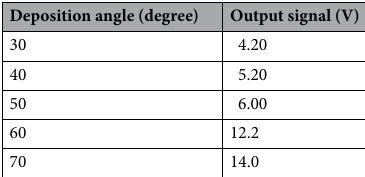
Table 4. Detector output—deposition angle curve after TEA-CO 2 laser pulse illumination.